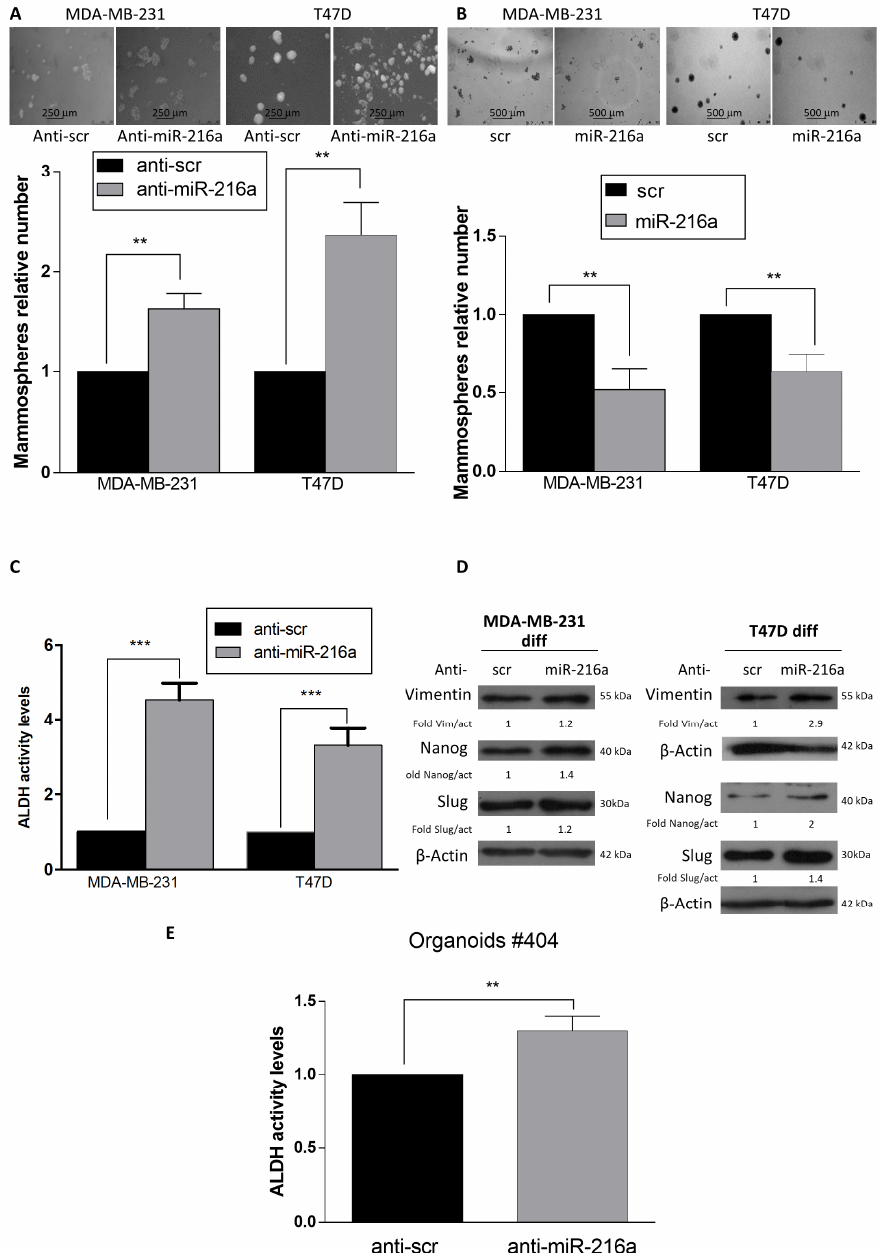
Figure 3. MiR-216a-5p increases stemness phenotype in di ff erentiated breast cancer cells. ( A ) MiR-216a anti-sense oligonucleotide increases the number of mammospheres when transfected into di ff erentiated MDA-MB-231 cells. Images were taken at 10x magnification, scale bar 250 µ m. ( B ) MiR-216a overexpression decreases the number of stem cells in MDA-MB-231 and T47D cultures, as assessed by mammosphere assay. Images were taken at 5x magnification, scale bar 500 µ m. ( C ) miR-216a downregulation, mediated by anti-miR-216a transfection, increases ALDH in MDA-MB-231 and T47D di ff erentiated cell cultures. ( D ) Downregulation of miR-216a leads to a higher expression of stemness and EMT markers in di ff erentiated MDA-MB-231 and T47D cells, as assessed by Western blotting. ( E ) ALDH activity increases after transfection with miR-216a anti-sense in patient-derived organoid cultures. Data are mean values ± SD of three independent experiments. Significance was calculated using Student’s t-test; **, p < 0.01, ***, p <